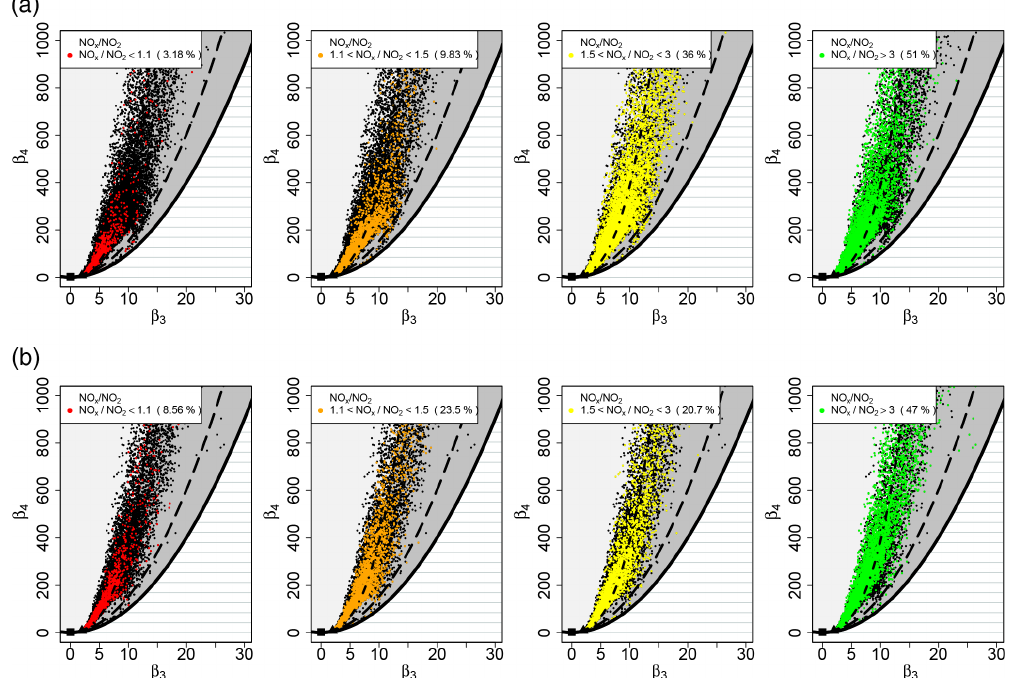
Figure 5. Location of the sample couples ( β 3 , β 4 ), black dots, from MI1 (upper panel) and MI2 (lower panel) in the skewness–kurtosis plane with theoretical distribution reference domains. Red dots represent PNSDs with ratio NO x / NO 2 between 1 and 1.1, orange dots 1.1 < NO x / NO 2 < 1.5, yellow dots 1.5 < NO x / NO 2 < 3 and green dots NO x / NO 2 >